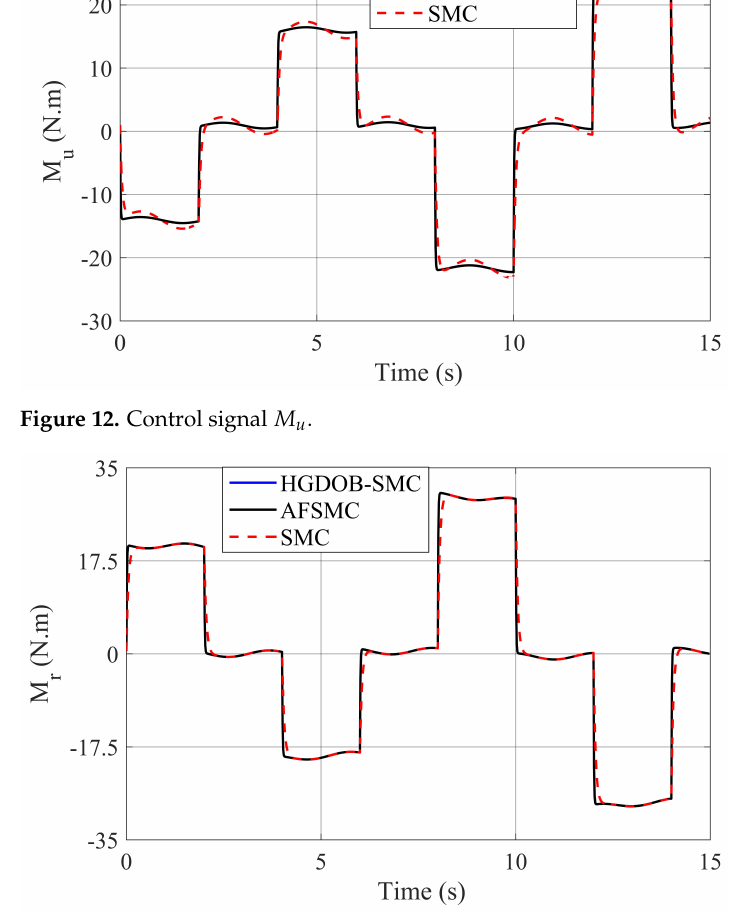
Figure 13. Control signal M r